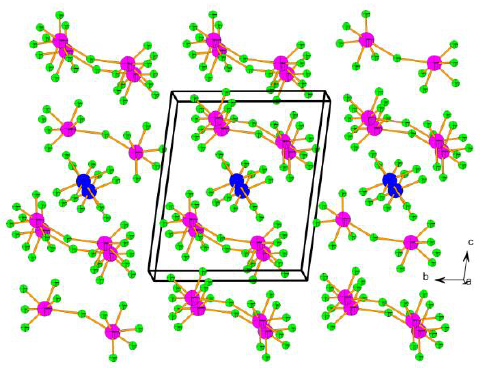
Figure 8. Packing of the [Xe 2 F 11 ] + cations and [MF 6 ] 2– anions in the crystal structures of [Xe 2 F 11 ] 2 [MF 6 ] (M = Pb, Sn). Copyright (2019) Wiley. Used with permission from Ref. [37]. The single crystal structure determination of [XeF 5 ] 4 [Sn 5 F 24 ] reveals that it is built of two- dimensional ([Sn 5 F 24 ] 4– ) ∞ grids and the [XeF 5 ] + cations located between them. The two-dimensional grids have a wave-like conformation (Figure 9). The ([Sn 5 F 24 ] 4– ) ∞ layer contains, both six- and seven- coordinated Sn(IV) interconnected by bridging fluorine atoms (Figure 9). It is a unique example of Sn(IV)-fluoride compound that does not consist just of [SnF 6 ] 2– anions. The coordination of Sn(IV) by seven fluorine atoms is unprecedented.